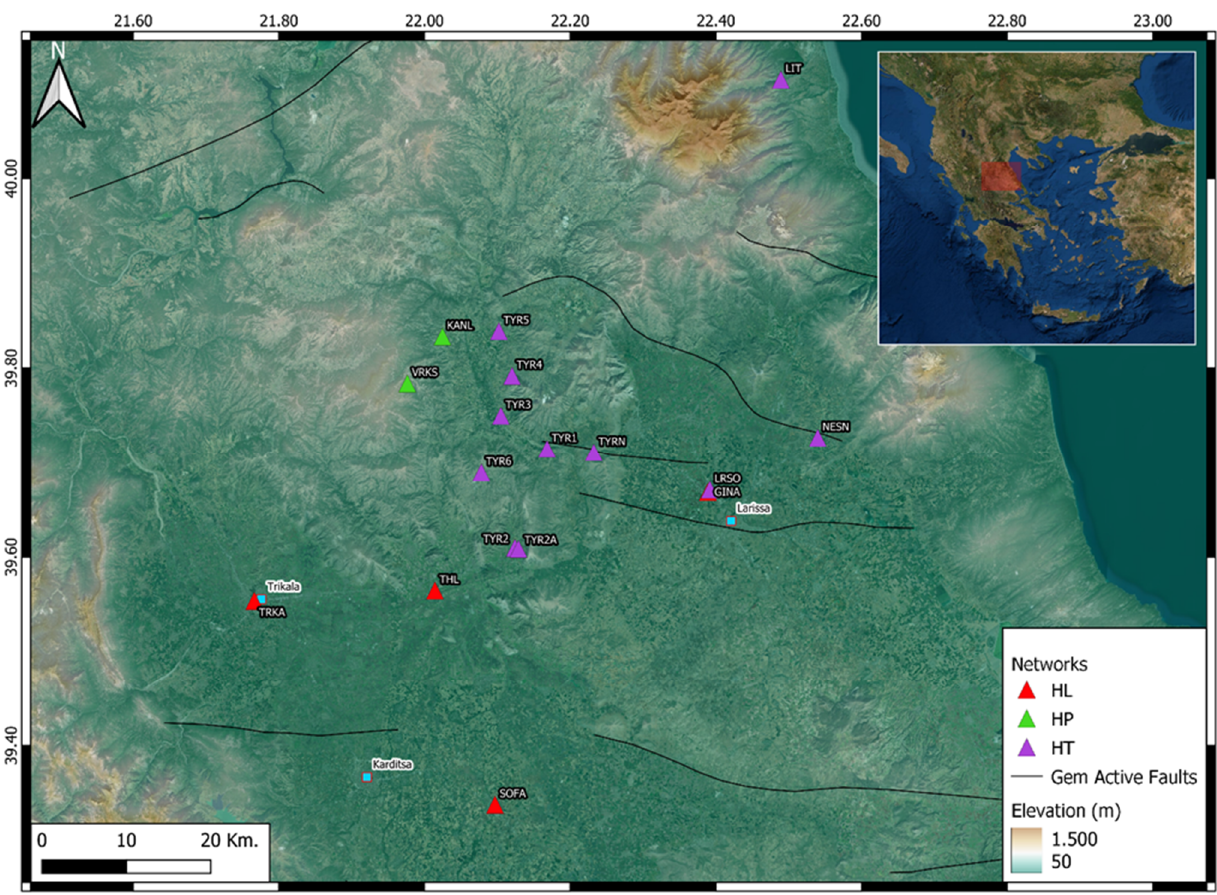
Figure 2. Geographical distribution of the Hellenic Unified Seismological Network’s stations in the region of Thessaly. Green triangles represent the seismological stations belonging to the University of Patras, purple triangles denote the portable network installed by the Aristotle University of Thessaloniki immediately after the earthquake, and the red triangles are the stations of the National Observatory of Athens. The light blue color represents the cities near the epicenter.